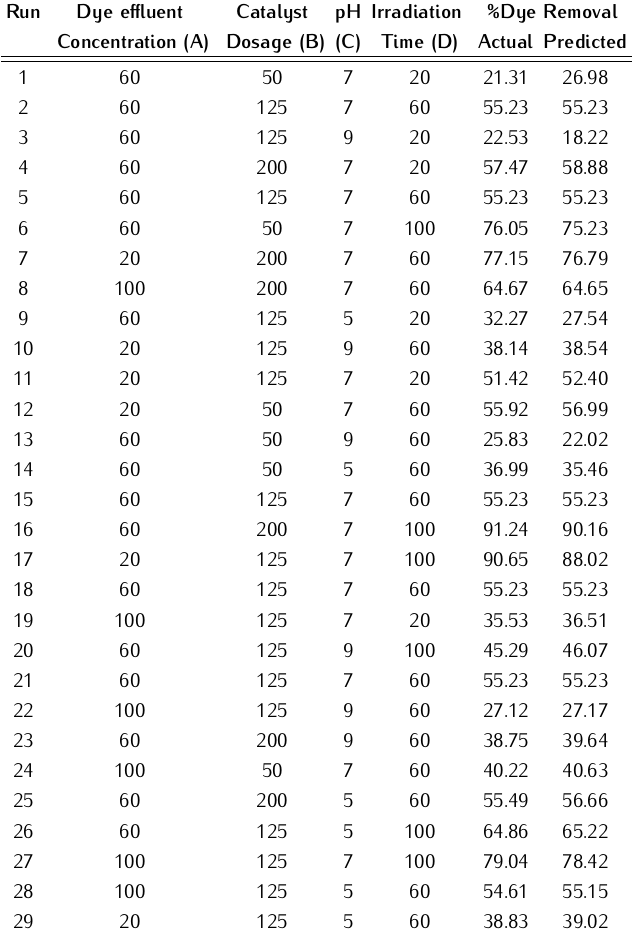
Table 3. Experimental design and response of the Box-Behnken design for the solar induced photo catalytic decolourization of dye